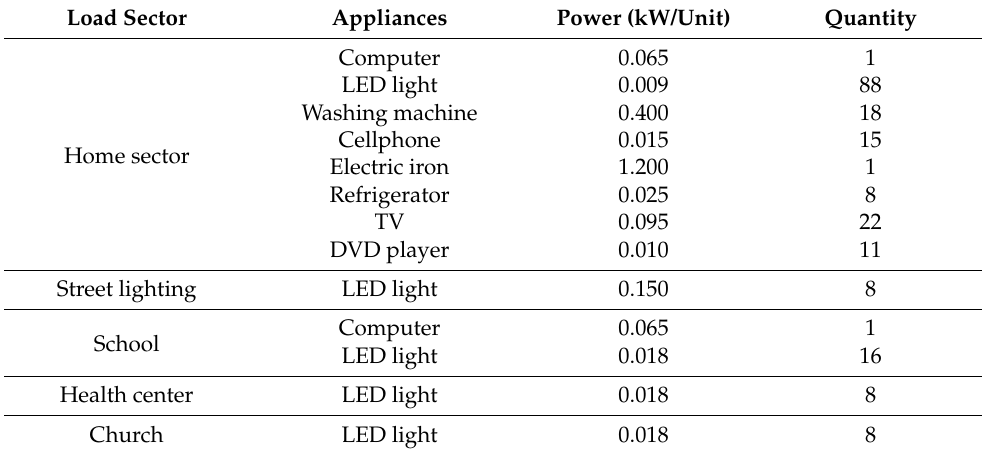
Table 1. Electrical load in Bellavista community (from [16]).